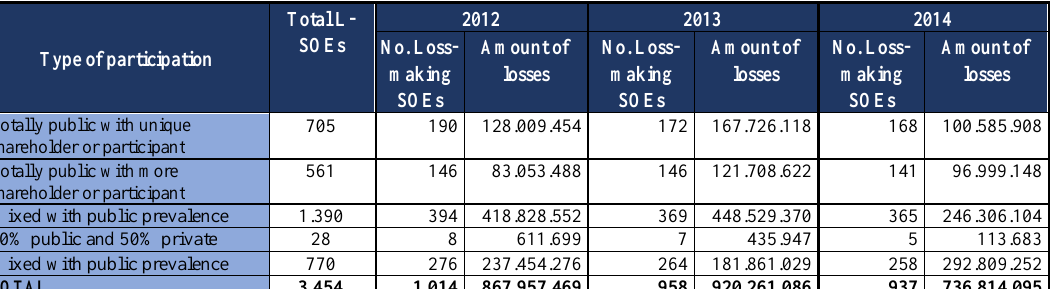
Total L- 2012 2013 2014 SOEs No. Loss- Amount of No. Loss- Amount of No. Loss- Amount of making losses making losses making losses SOEs SOEs SOEs 705 190 128.009.454 172 167.726.118 168 100.585.908 96.999.148 1.390 394 418.828.552 369 448.529.370 365 246.306.104 958 920.261.086 937